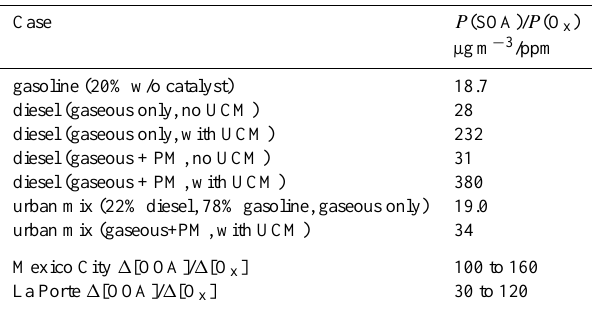
Table 2. Summary of P (SOA)/ P (O x ) calculations for diesel and gasoline